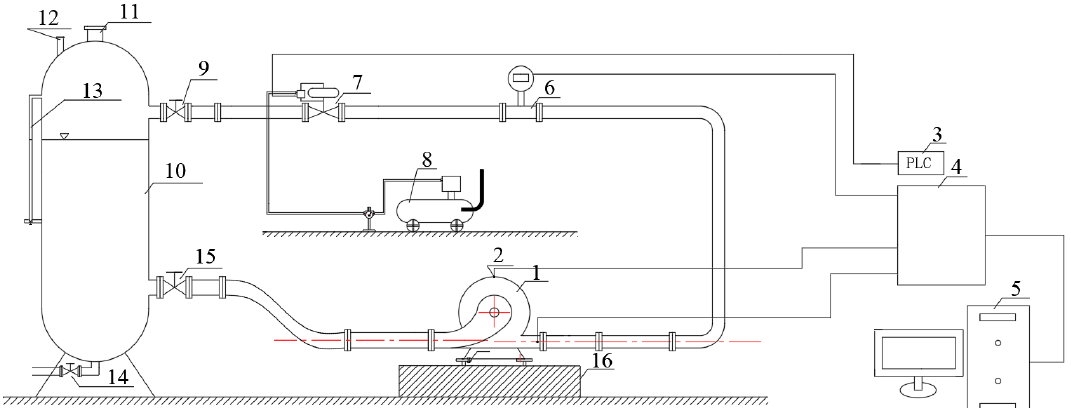
Figure 2. Sketch diagram of the experimental system for rapid reduction of flow rate. 1 Model pump, 2 Pressure sensor, 3 PLC controller, 4 Data collection systems, 5 Computer, 6 Electromagnetic flowmeter, 7 Pneumatic control valve, 8 Air compressor, 9 Backwater valve, 10 Water tank, 11 Vent hole, 12 Inlet hole, 13 Level gauge, 14 Drain valve, 15 Water outlet valve, 16 Base.